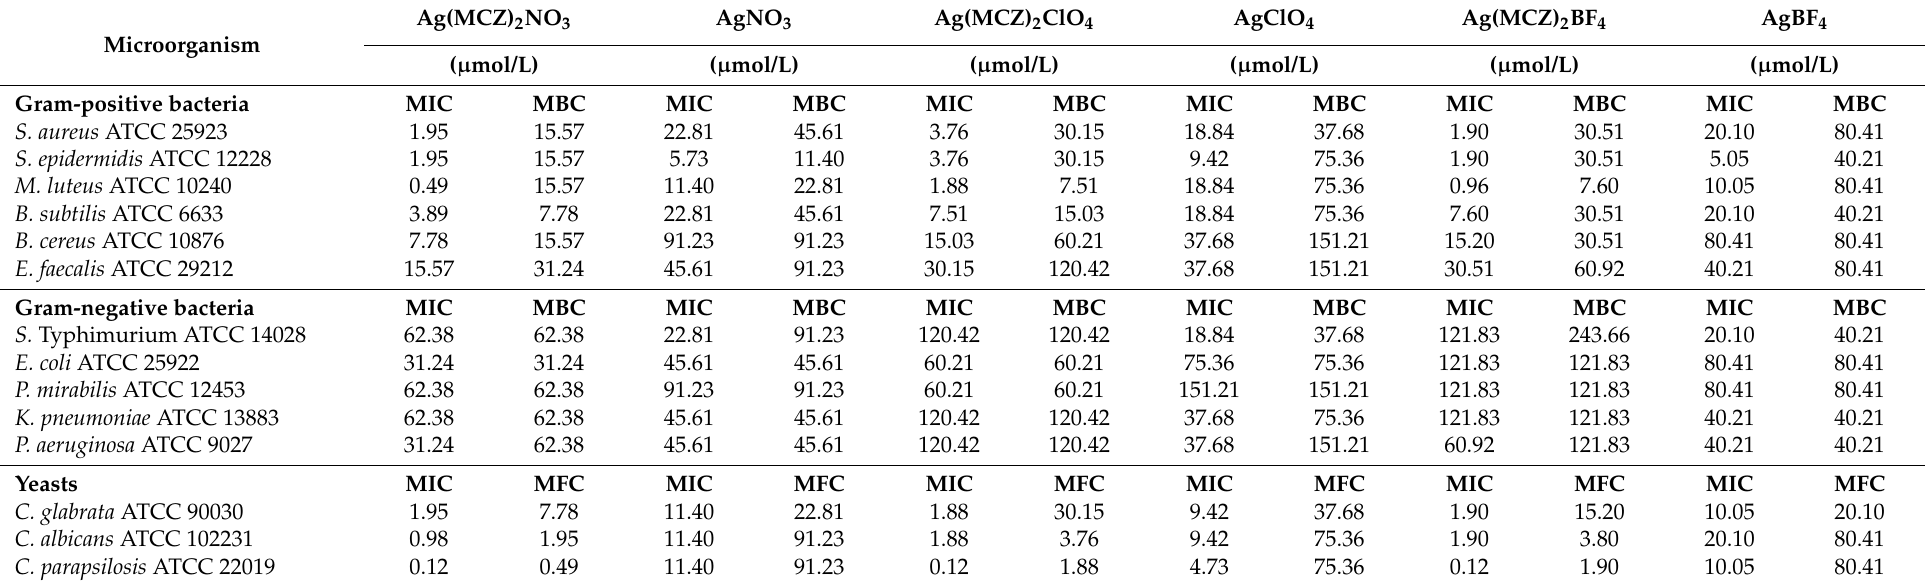
Table 4. Antimicrobial activity defined as minimal inhibitory concentration (MIC) and minimal bactericidal/fungicidal concentration (MBC/MFC) of silver(I) complexes, silver salts and reference compounds—miconazole (MCZ) and silver-sulfadiazine